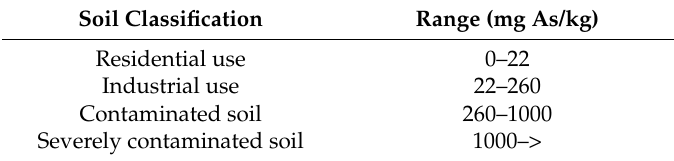
Table 1. Soil classification by arsenic values according to NOM-147-SEMARNAT/SSA1-2004.